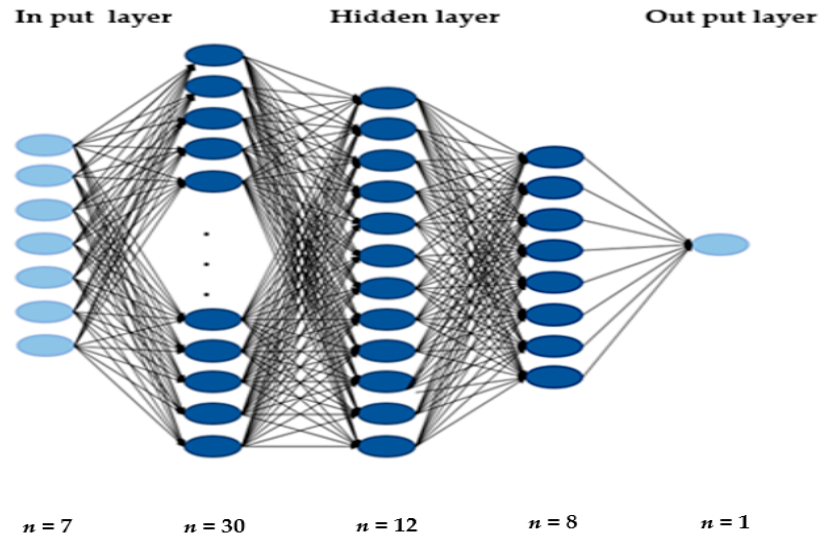
Figure 3. DNN model for classifying and predicting on the effects of nutritional intake on over- weight/obesity, dyslipidemia, hypertension and T2DM.